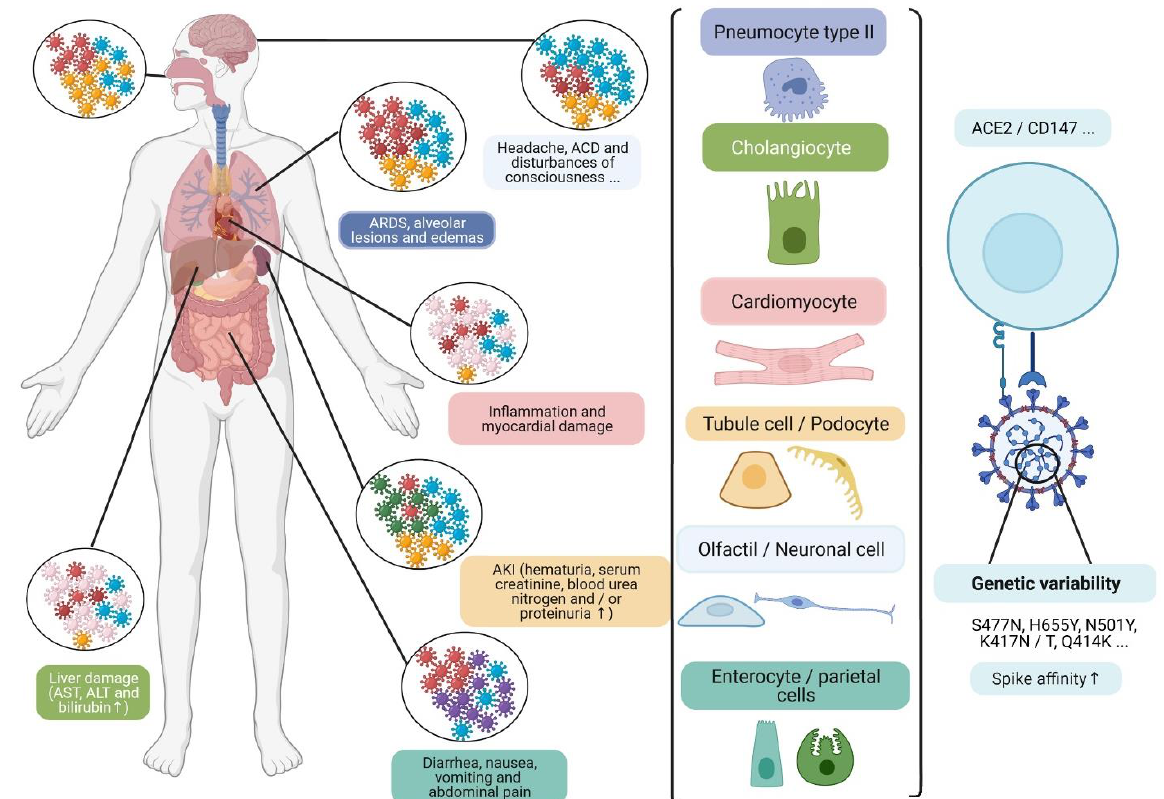
Figure 3. The development of viral quasi-species can modulate viral interaction with cell receptors in several tissues (type II pneumocytes, cholangiocytes, cardiomyocytes, tubular and podocyte cells, olfactory and neuronal cells, and enterocyte and parietal cells), particularly ubiquitous CD147 and ACE2R. This is, at least in part, due to the development of certain mutations, which may be associated with some clinical symptoms, and the elevation of certain biochemical markers in patients. Acute cerebrovascular disease (ACD); acute kidney injury (AKI); aspartate transaminase (AST); alanine transaminase (ALT); angiotensin-converting enzyme 2 receptor (ACE2R); differentiation cluster 147 (CD147) [48]. (Designed by biorender) .